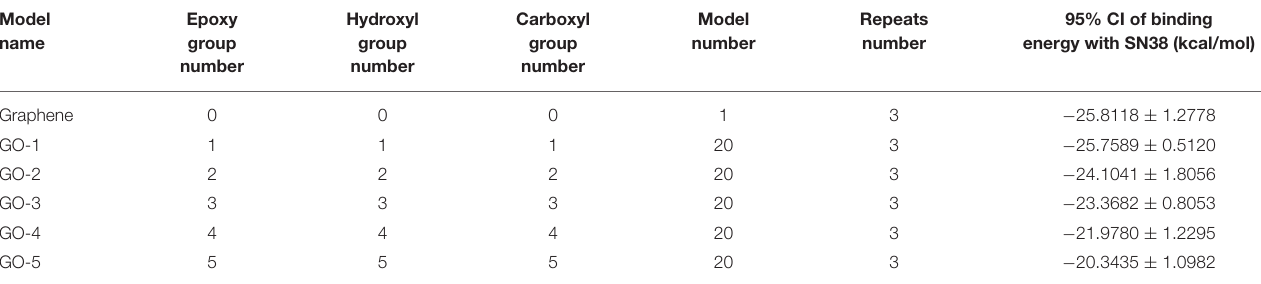
TABLE 1 | The 95% confidence intervals of binding energies between the graphene/GO model and SN38 derived from three runs with the two-layer cascade